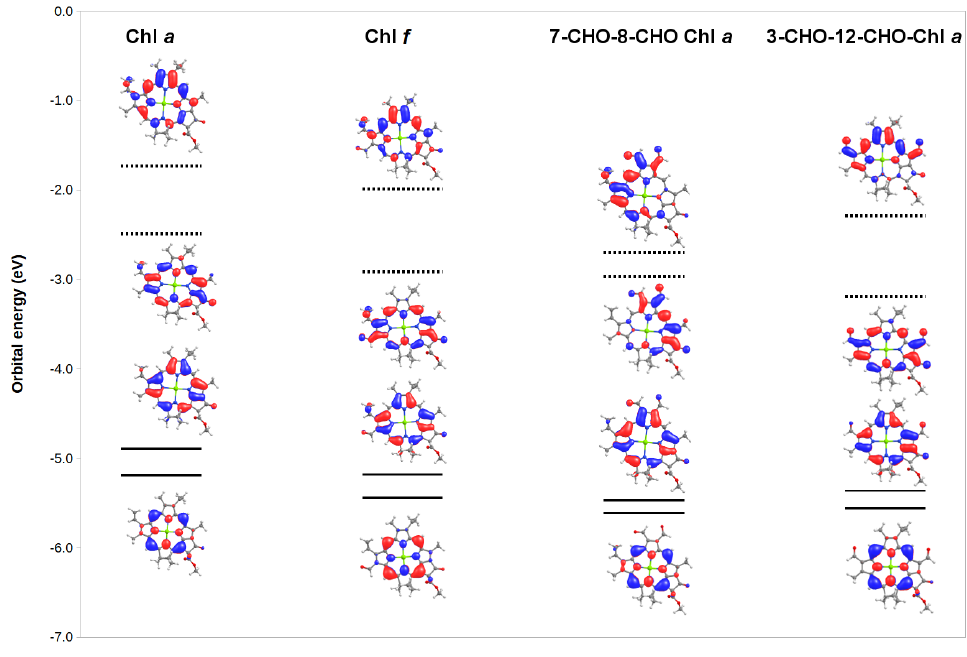
Figure 5 MO correlation diagram for representative chlorophyll derivatives. The calculations em- ployed the B3LYP function, 6-31G* basis set. Full-size DOI: